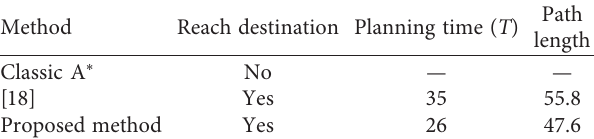
Table 4: Results under dynamic environment. Method